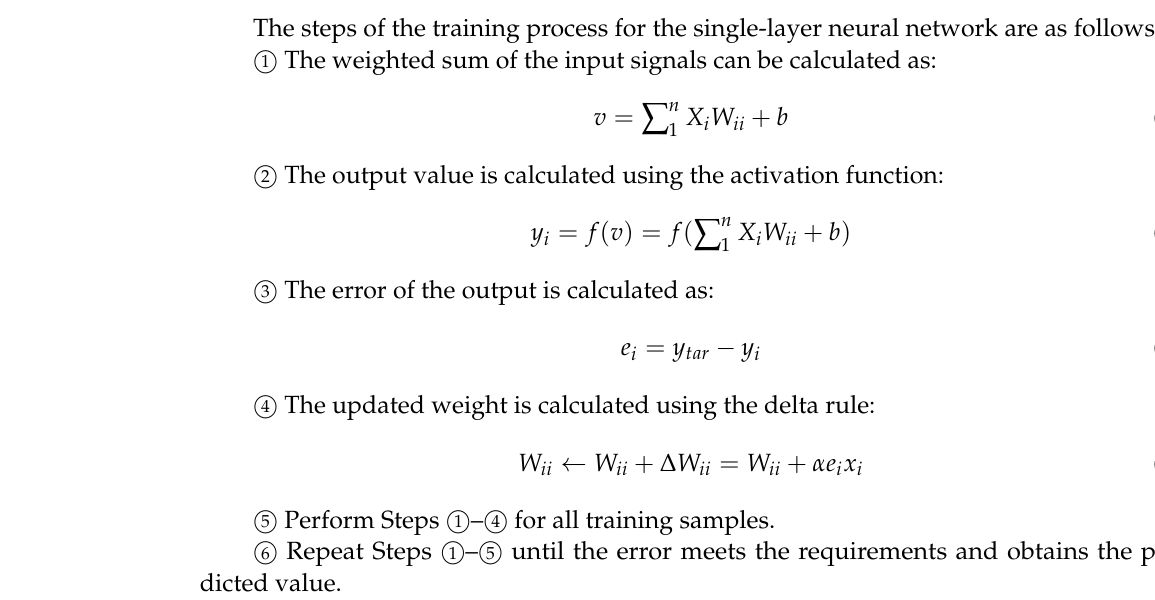
Figure 1. Schematic of the network in an Artificial Neural Network Model.